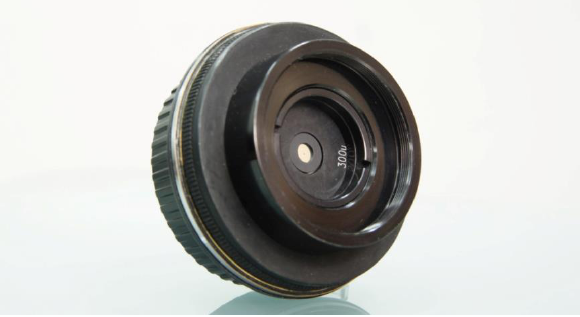
Figure 1. The pinhole lens with Canon bayonet